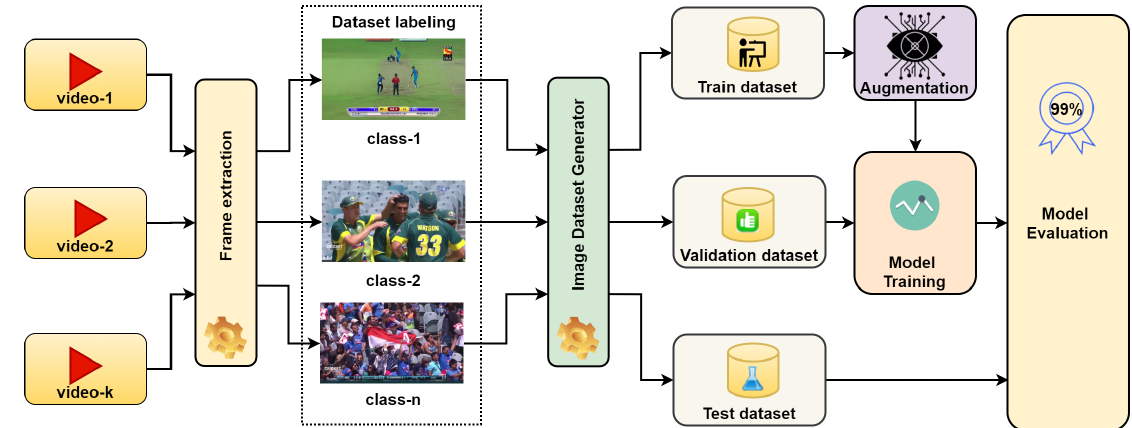
Figure 2. Proposed model training and evaluation block